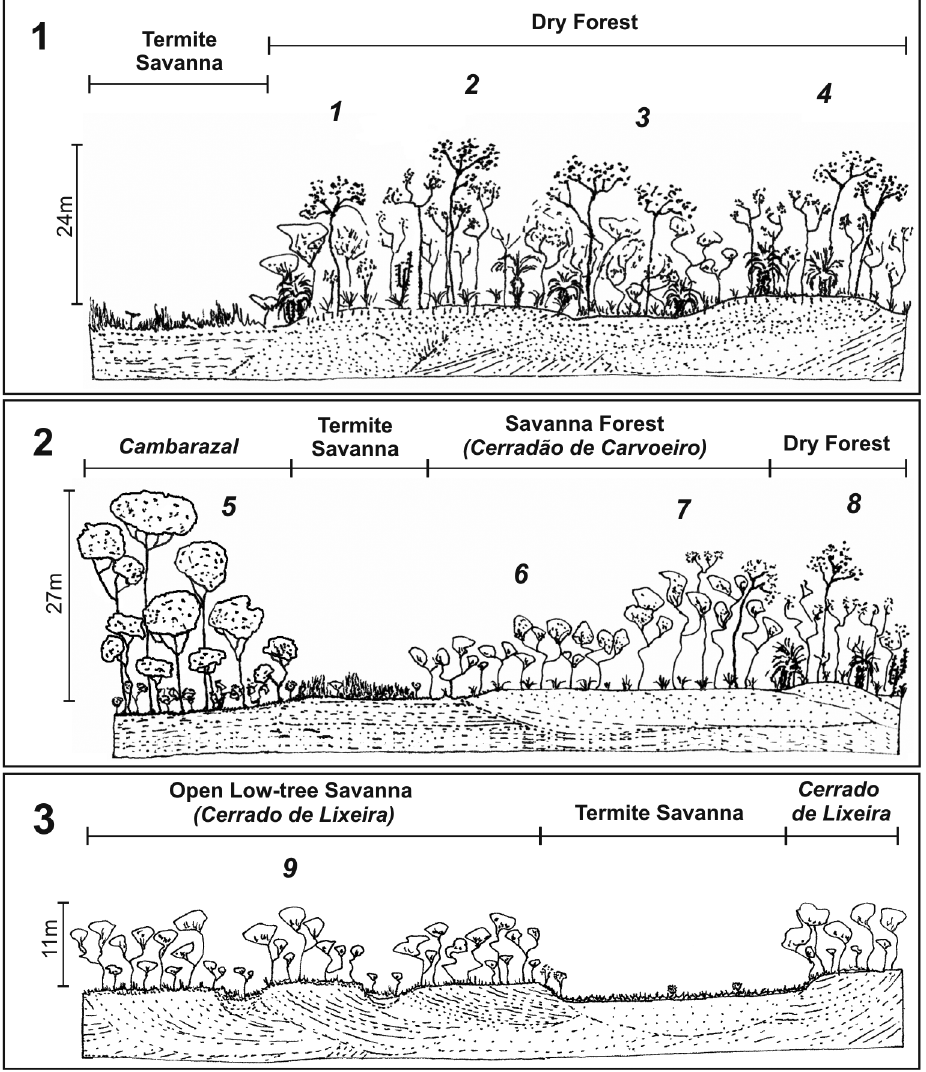
Figure 2 - Phytophysiognomies and the respective vegetation facies sampled in transects 1, 2 and 3 in RPPN SESC Pantanal, Brazilian Pantanal, where: 1. Transitional Dry Forest (DF) with Scheelea phalerata ; 2. DF with S. phalerata and Callisthene fasciculata ; 3. DF with S. phalerata and Myracrodruon urundeuva ; 4. DF with S. phalerata , M. urundeuva and C. fasciculata ; 5. Cambarazal ; 6. Cerradão de Carvoeiro with Lafoensia pacari ; 7. Cerradão de Carvoeiro with Magonia pubescens ; 8. DF with S. phalerata , M. urundeuva and Combretum leprosum ; 9. Cerrado de Lixeira with Terminalia